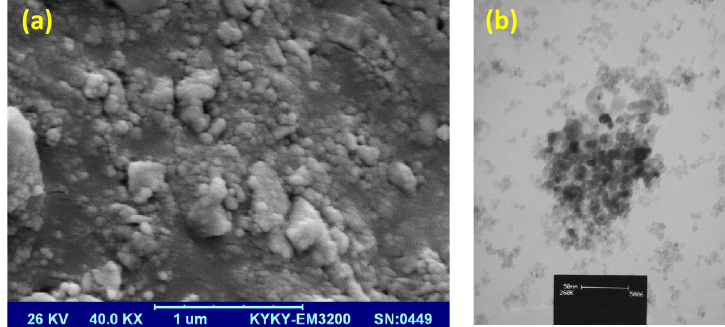
Fig. 3. (a) SEM image, and (b) TEM images of the prepared nickel ferrite